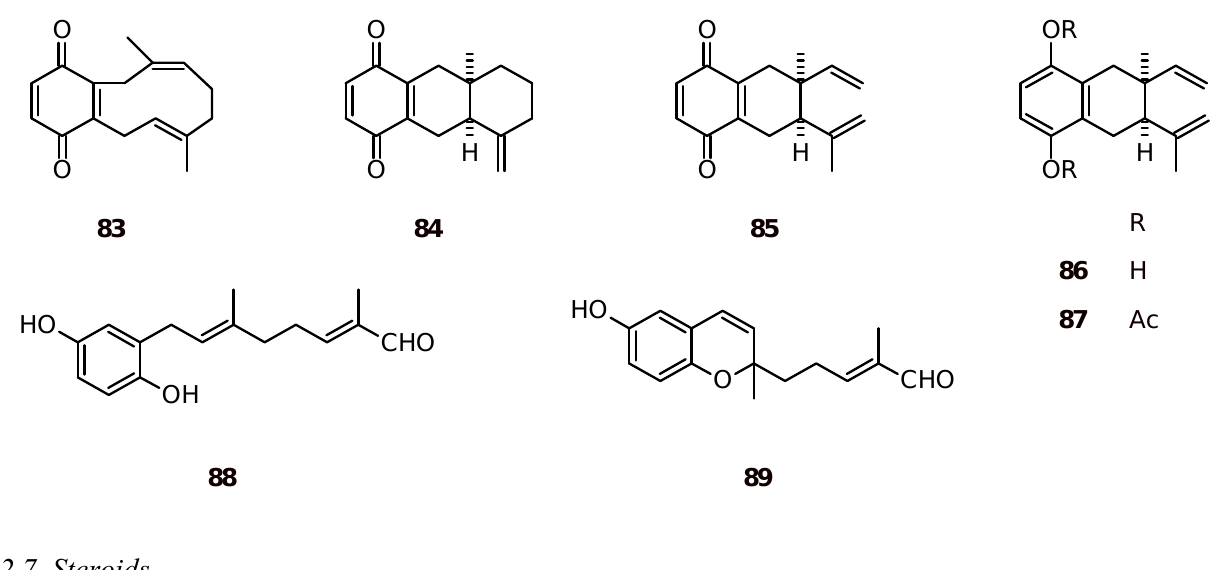
Figure 9. Structures of terpenoid benzoquinones and analogues 83-89